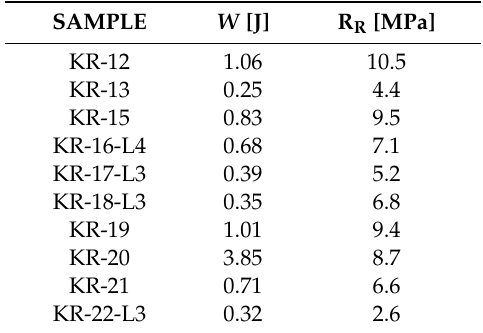
Table 2. Results for work done in Brazilian tests and tensile strength. Figure 4. Strength testing machine “Instron” and dolomite sample “KR-15” in a Brazilian test. SAMPLE